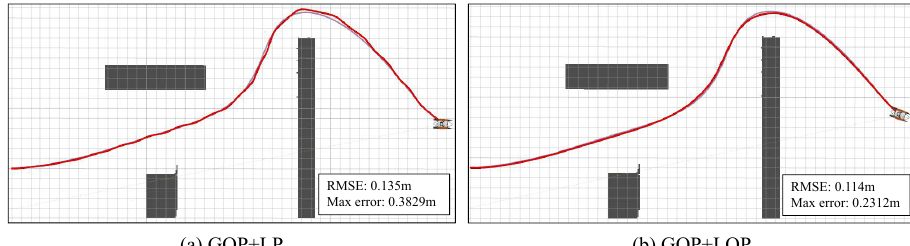
Figure 8. Tracking control performance comparison. GOP+LP denotes the tracking control method without optimization, i.e., the PID control. GOP+LOP denotes the proposed method with NMPC control.